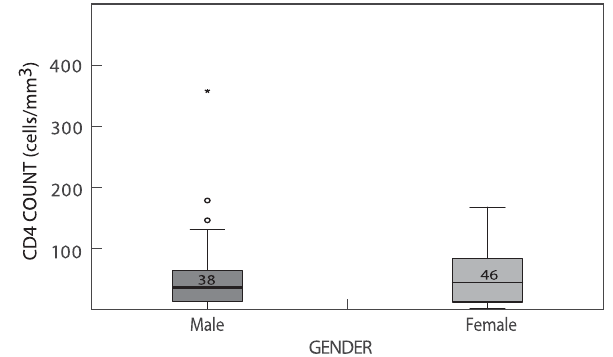
Figure 2: CD4 count relative to the number of patients admitted to PMMH with